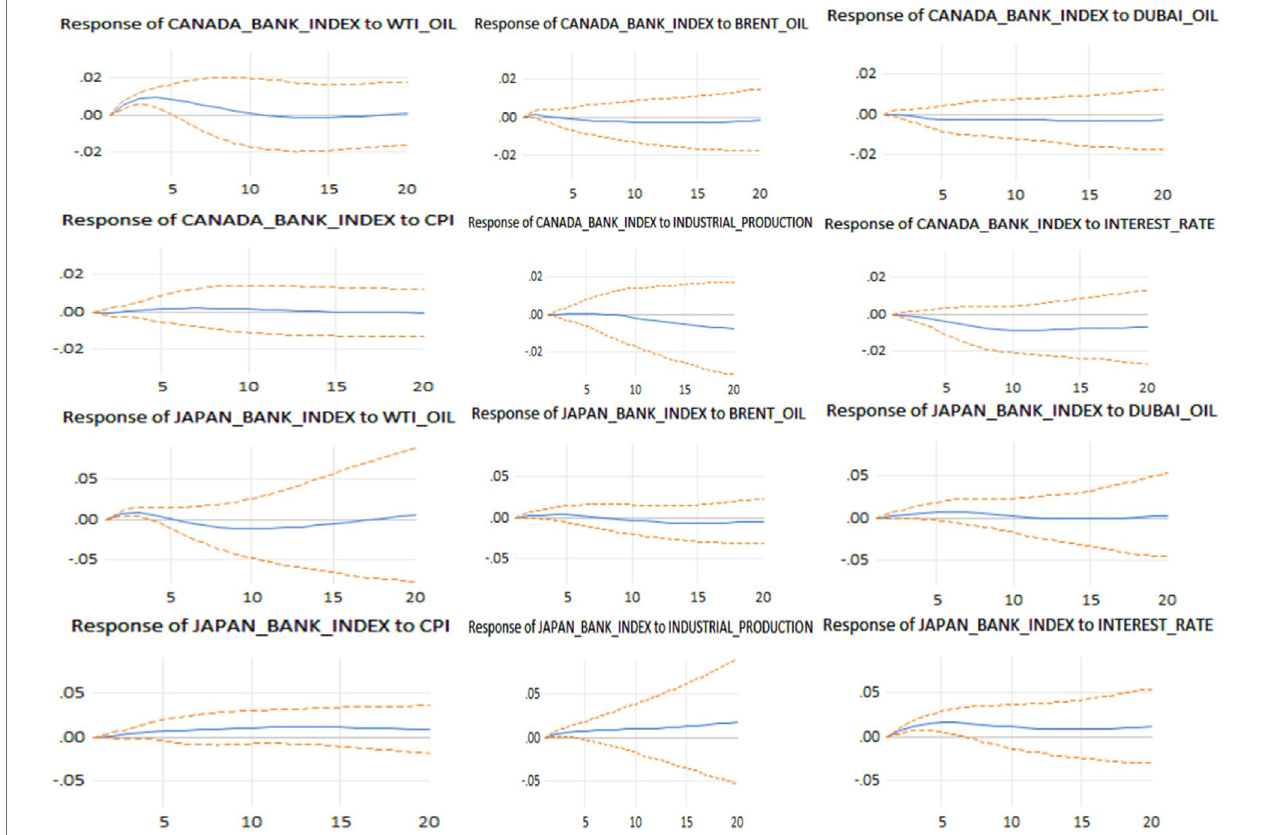
FIGURE 2 | Impulse response function analysis: Canada,